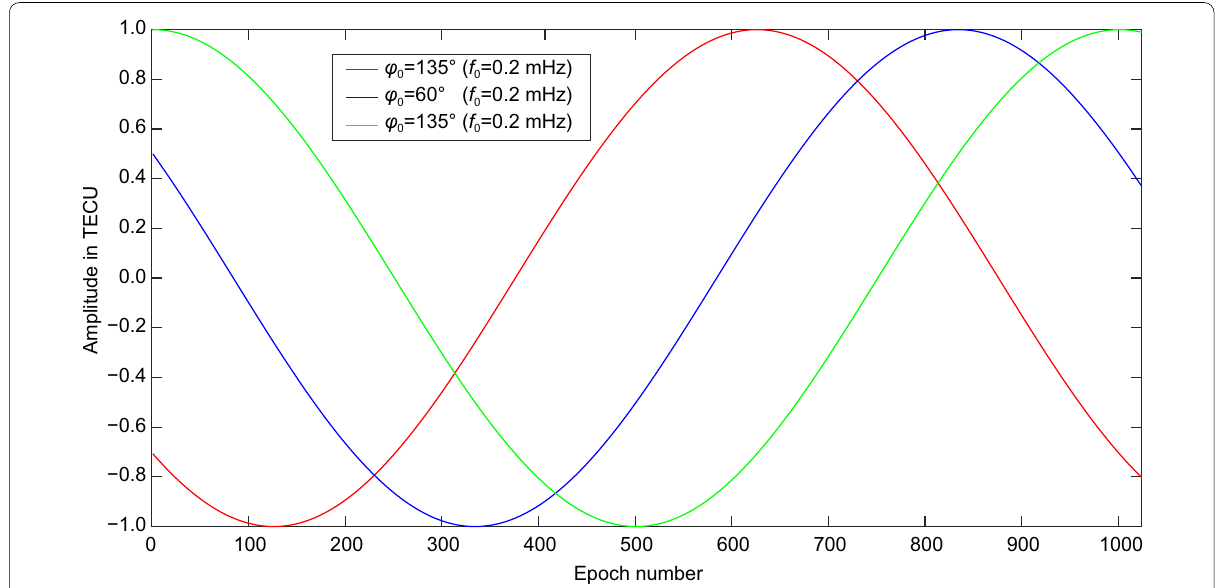
Fig. 10 The simulation results of TID with same direct component, amplitude, and frequency but different initial